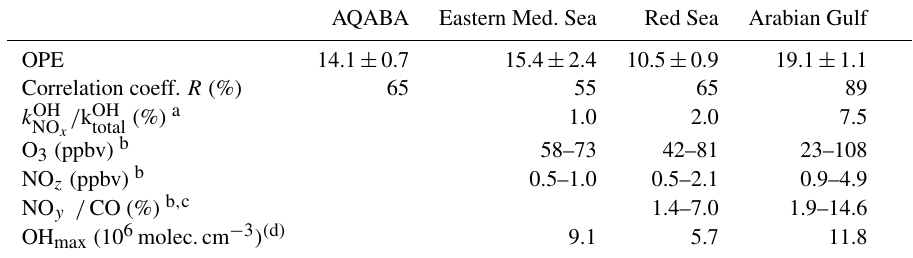
Table 4. Ozone production efficiencies (OPEs) for AQABA and the individual